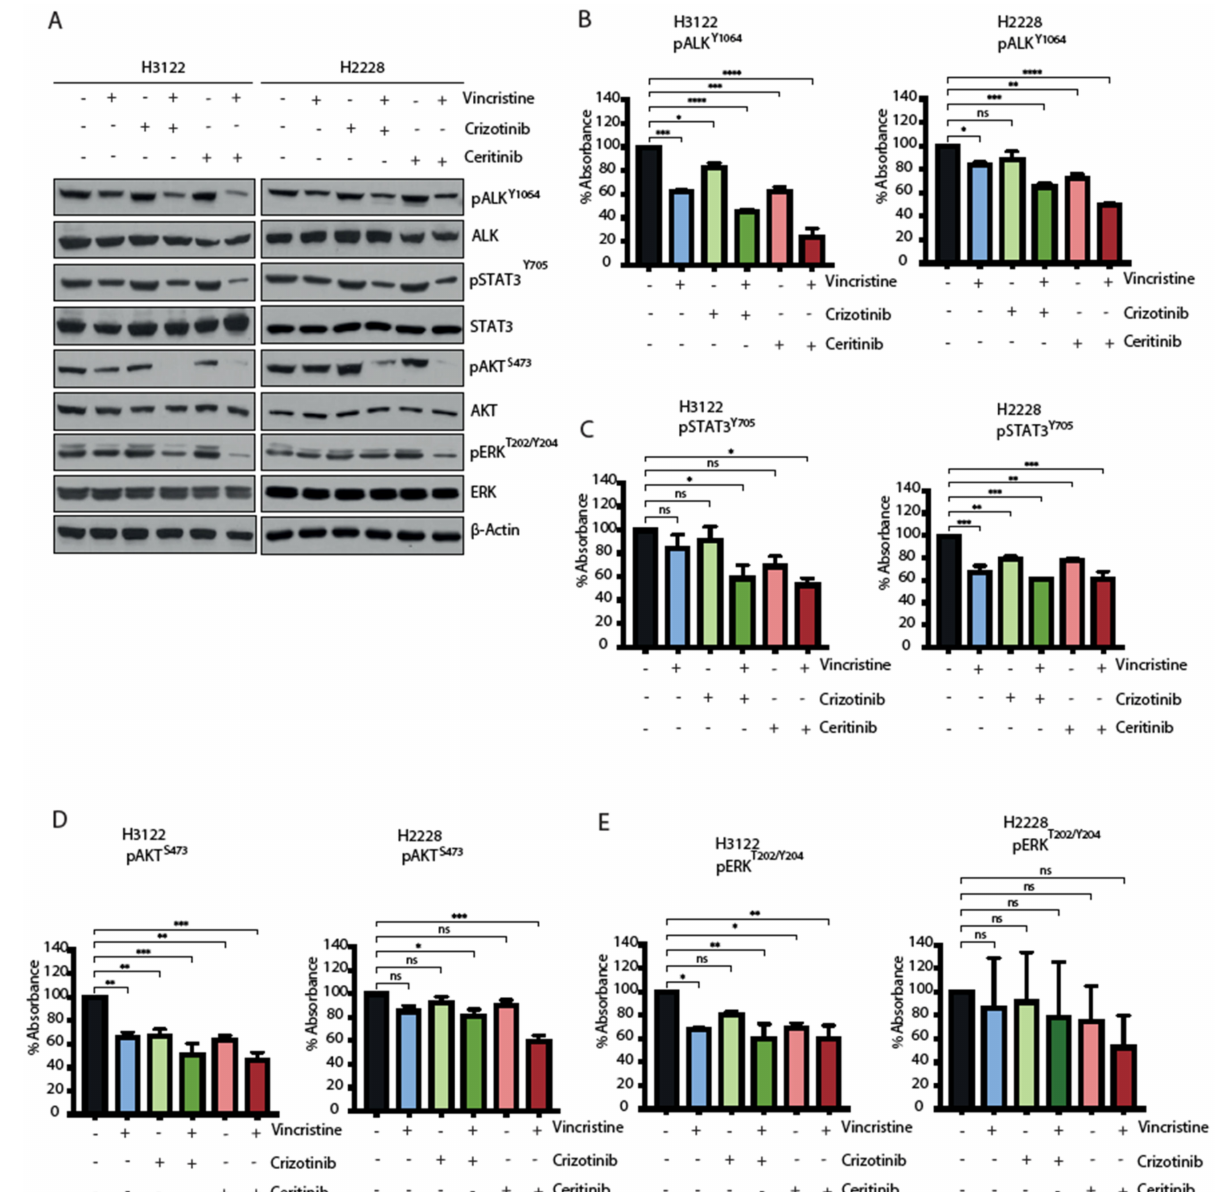
Figure 5. The combination of ALK inhibitor and vincristine impairs downstream signalling of RAS/MAPK, PI3K/AKT and JAK/STAT3 in H3122 but not H2228 cells. ( A ). H3122 and H2228 cells were serum starved overnight and then treated with the indicated inhibitors for 3 h (crizo- tinib/ceritinib 400 nM and vincristine 20 nM). Western blotting analysis for the indicated proteins was performed. β -actin was used as a loading control. ( B – E ). ELISA assay was used to quantify expressions of pALK Y1604 , pSTAT3 Y705 , pAKT S473 and pERK T202/Y204 proteins. Data represent